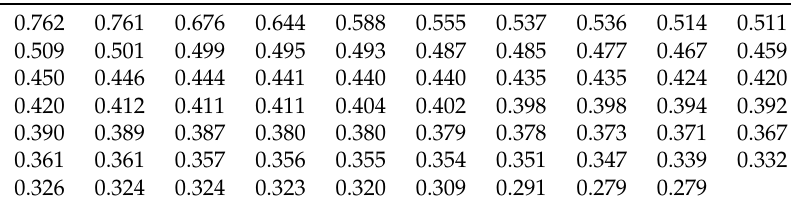
Table 5. Transformed Data Set 1.